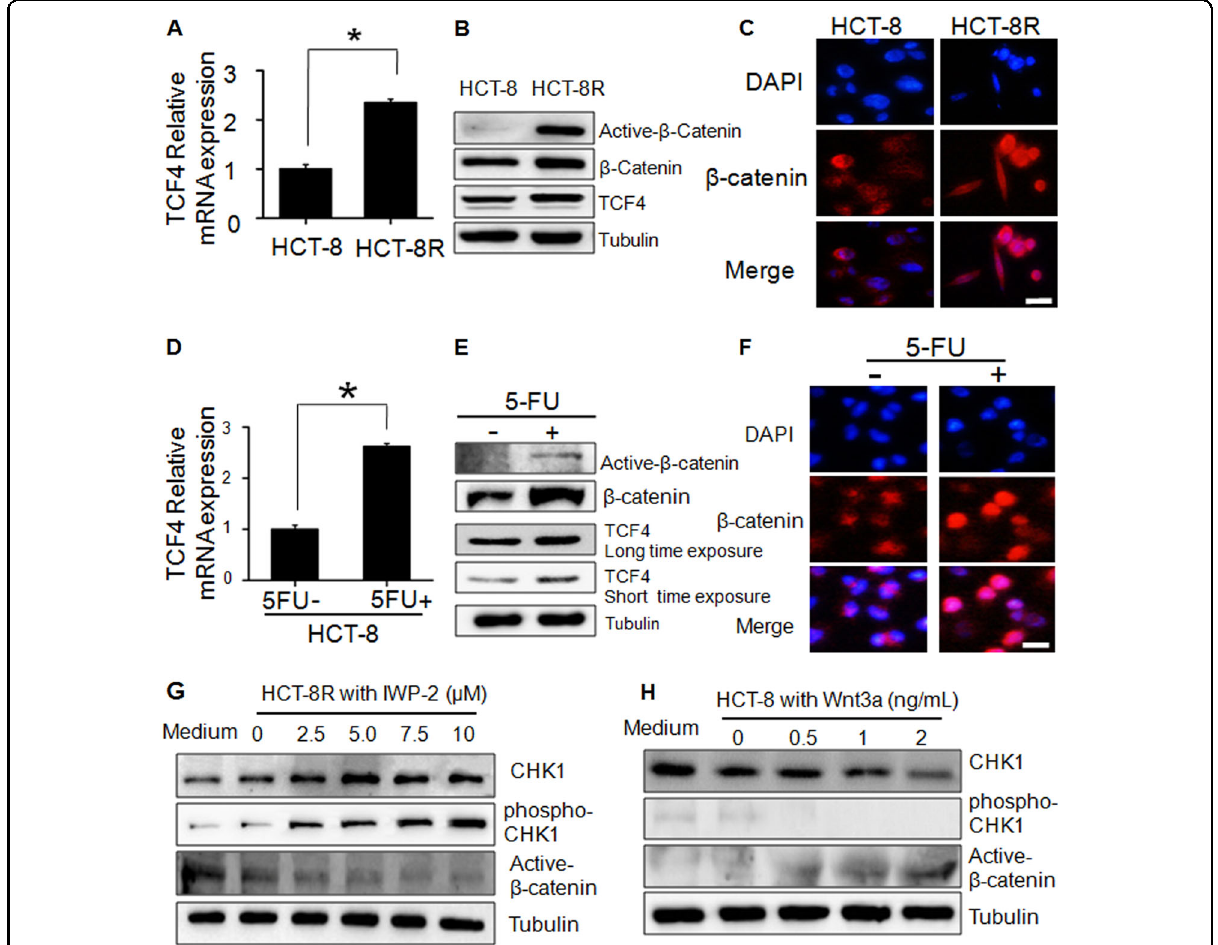
Fig. 4 5-FU-resistant cells are Wnt pathway-activated cells. a TCF4 mRNA expression was elevated in HCT-8R cells. The data represent the means ± SD from three independent experiments. * P < 0.05. b The elevated expression of TCF4, β -catenin, and active- β -catenin in HCT-8R cells was examined by immunoblot. c Immuno fl uorescence detection of β -catenin HCT-8R cells. Scale bar, 20 μ m. d TCF4 mRNA expression was elevated in 5- FU-treated HCT-8 cells. * P < 0.05. e The expression of TCF4, β -catenin, and active- β -catenin in HCT-8 cells (induced by 100 µg/mL 5-FU for 48 h) was examined by western blotting assay. f Immuno fl uorescence detection of β -catenin HCT-8 cells. Scale bar, 20 μ m. g IWP-2 ef fi ciently suppresses the expression of active- β -catenin, while CHK1 and p-CHK1 were upregulated in HCT-8R cells. h Wnt3a stimulated the expression of active- β -catenin, while CHK1 and p-CHK1 expression were suppressed by the enhanced Wnt